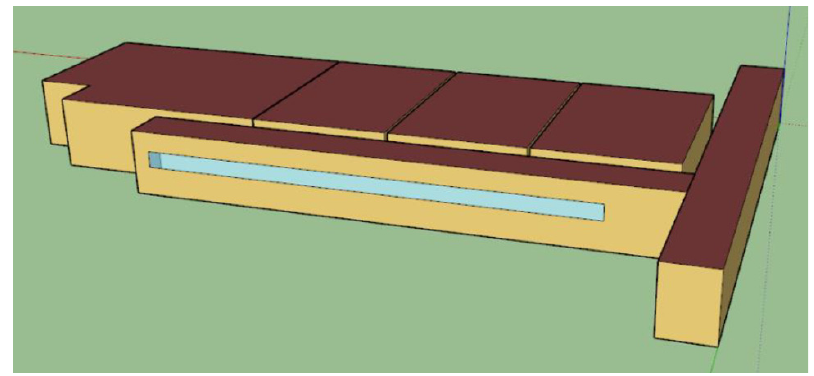
Figure 1. Geometrical model of the laboratories.